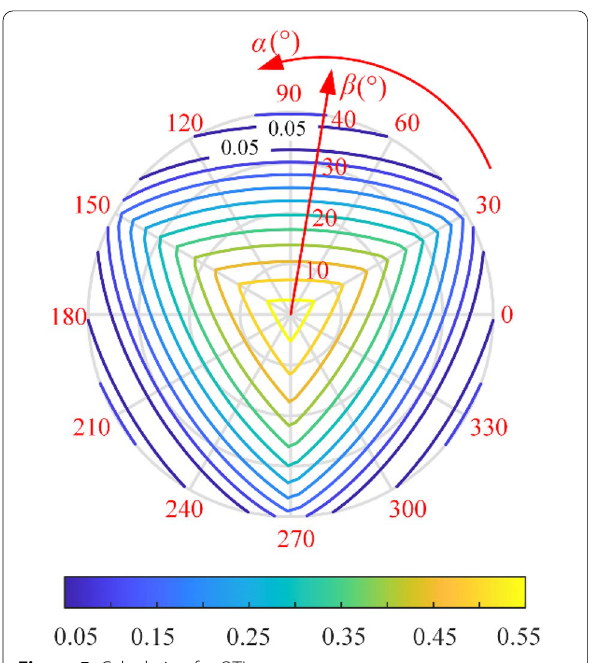
Figure 5 Calculation for OTI